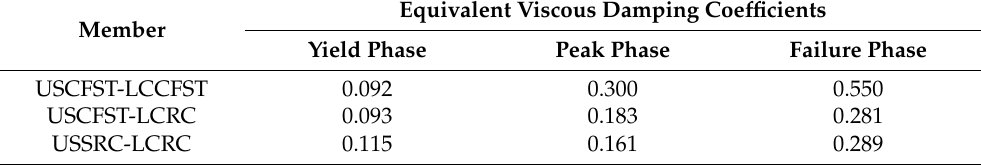
Table 11. Comparison of equivalent viscous damping coefficients of the three types of column con- nection components.